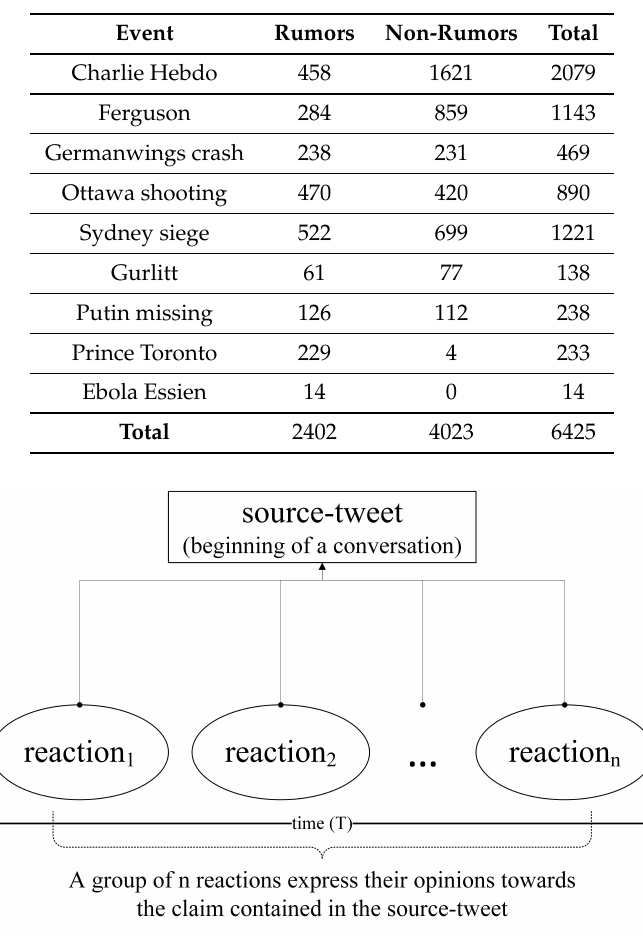
Table 2. The PHEME dataset with nine events.